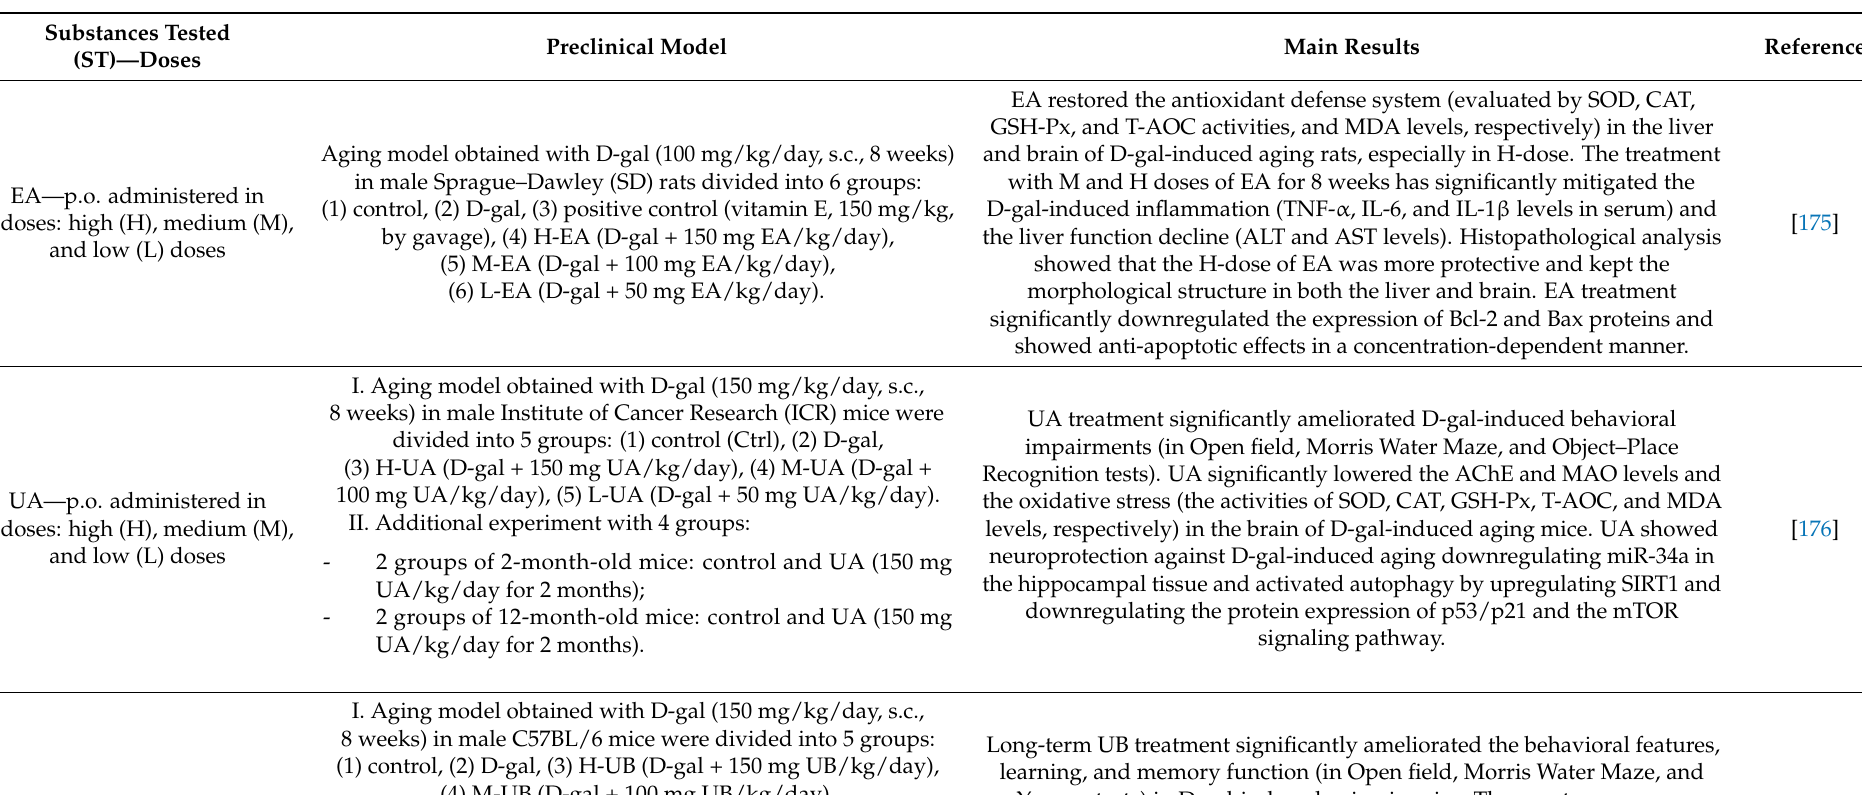
Table 3. Preclinical studies attesting the antioxidant, anti-inflammatory, and neuroprotective effects of ellagitannins, ellagic acid, or their metabolites in the